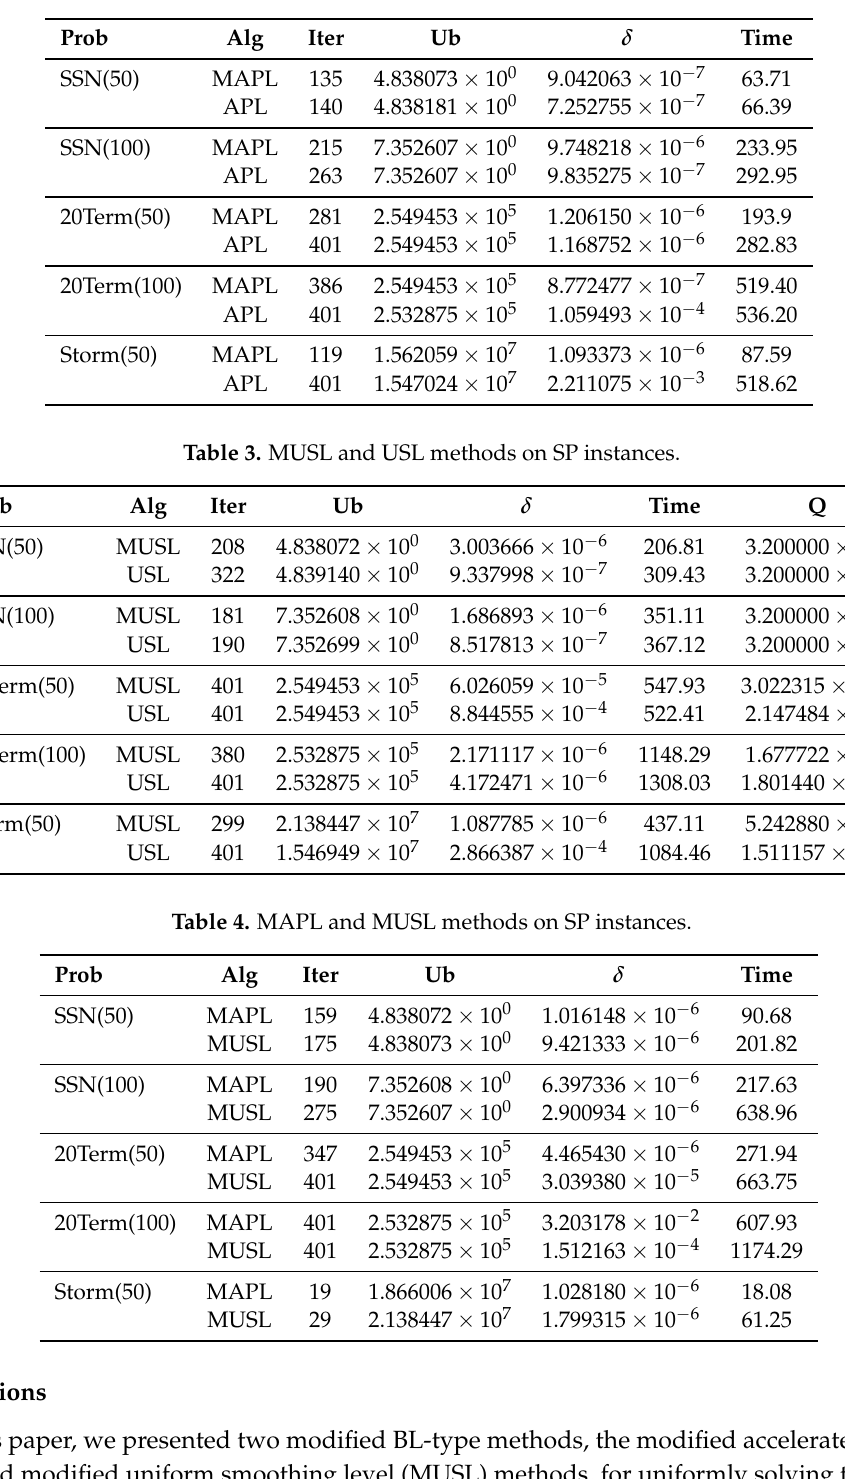
Table 2. MAPL and APL methods on SP instances.